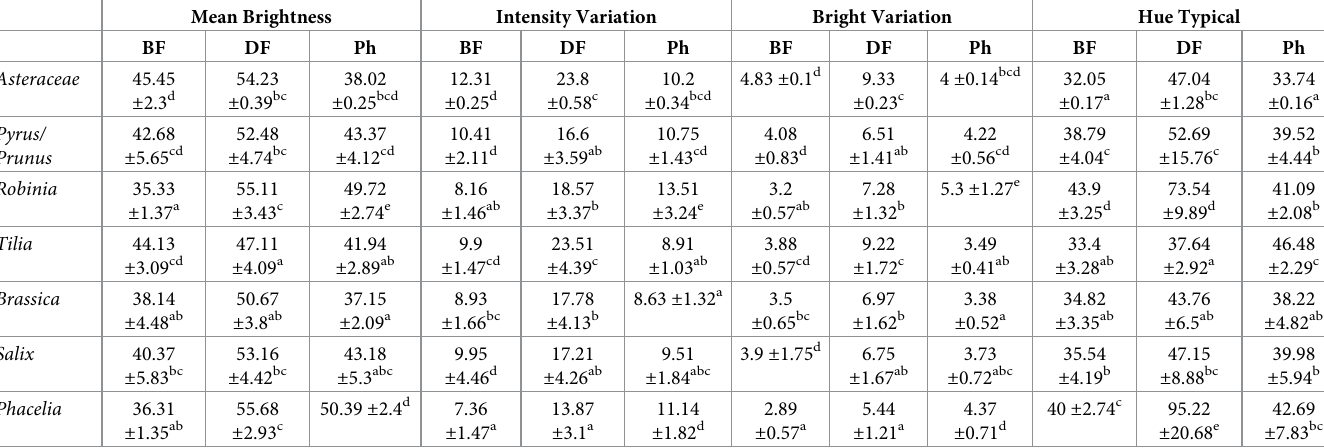
Table 8. Texture related colour descriptors of pollen grains.